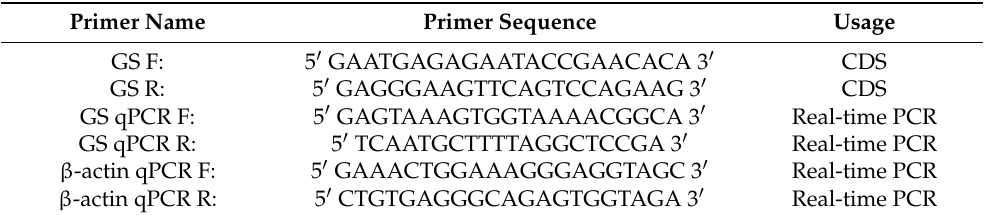
Table 1. Primers used in this